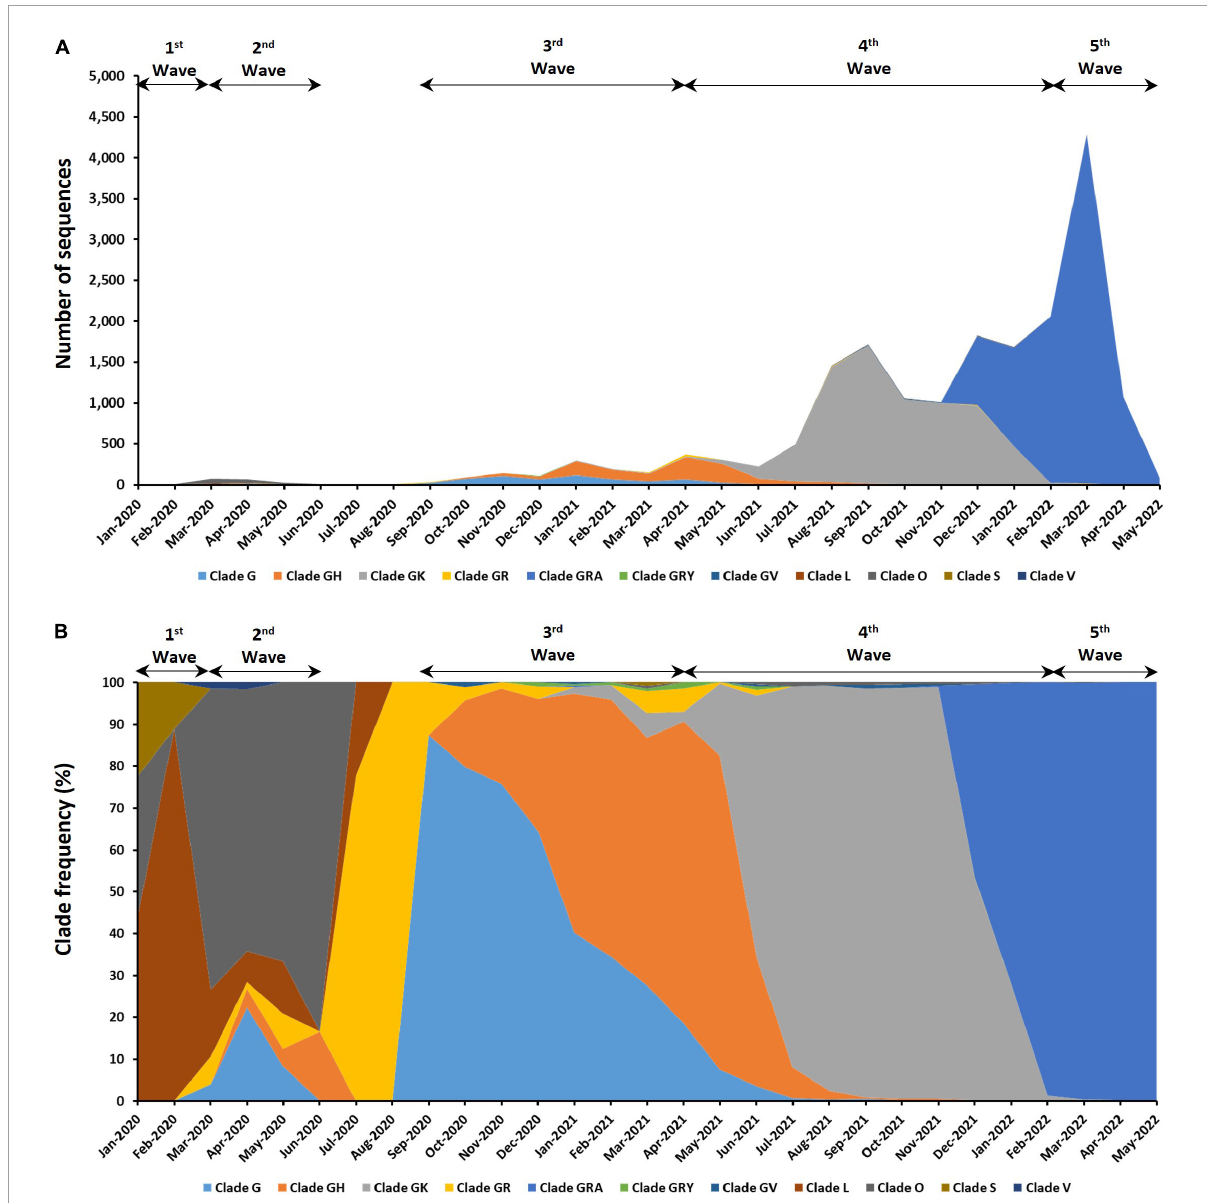
FIGURE2 Distribution of clades among the 18,871 genomic sequences in Malaysia. (A) Number of sequences based on clades. (B) Distribution of clade